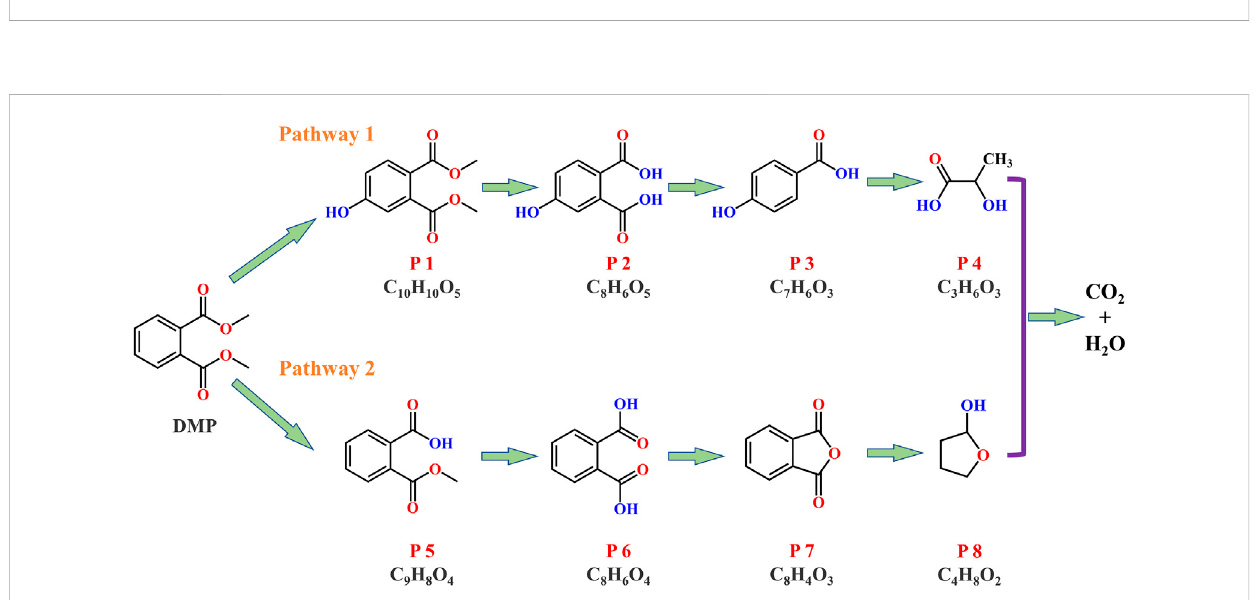
FIGURE 8 Possible degradation pathways of DMP degradation in CMB@1T-MoS 2 /PMS